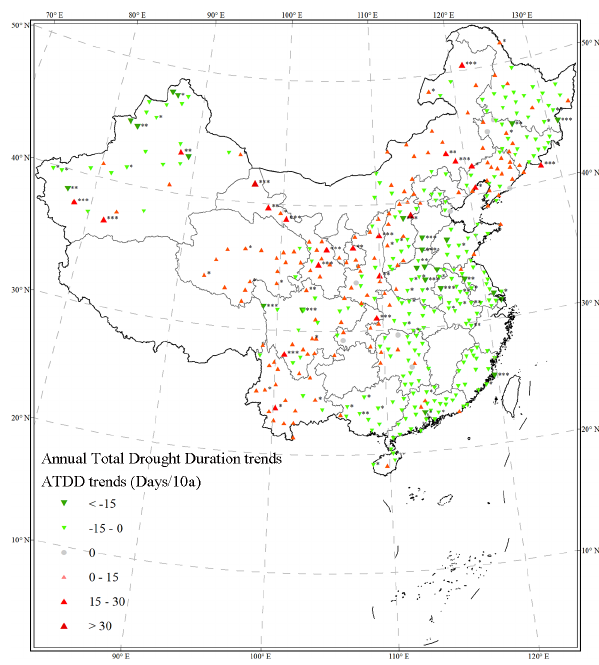
Figure 7. The spatial distribution of the changing trends of ATDD (the red and green triangles indicate increasing and decreasing trends, respectively. “***” denotes P value < 0 . 001, “**” denotes P value < 0 . 01, and “*” denotes P value < 0 .